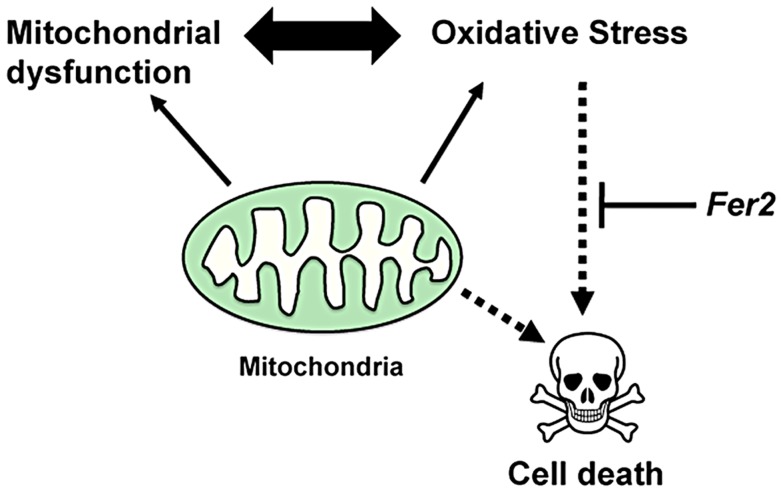
A model for the role of Fer2 in the survival of DA neurons.Mitochondrial dysfunction and oxidative stress are interdependent and are both known to mediate DA neuron death. Fer2 expression is upregulated in response to oxidative stress and counteracts PAM neuron degeneration.